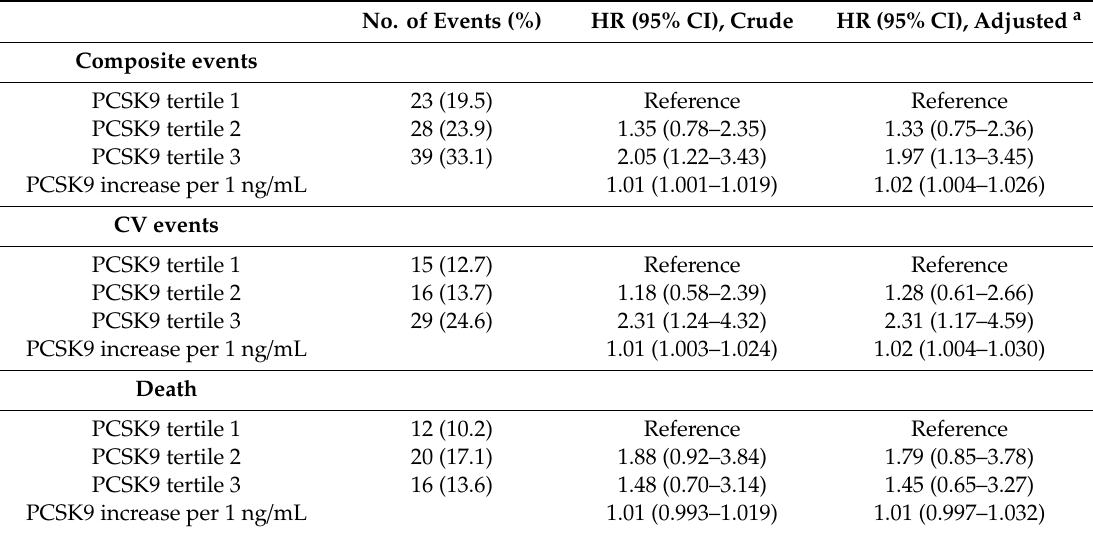
Table 4. Hazard ratios of plasma PCSK9 tertiles for CV events and